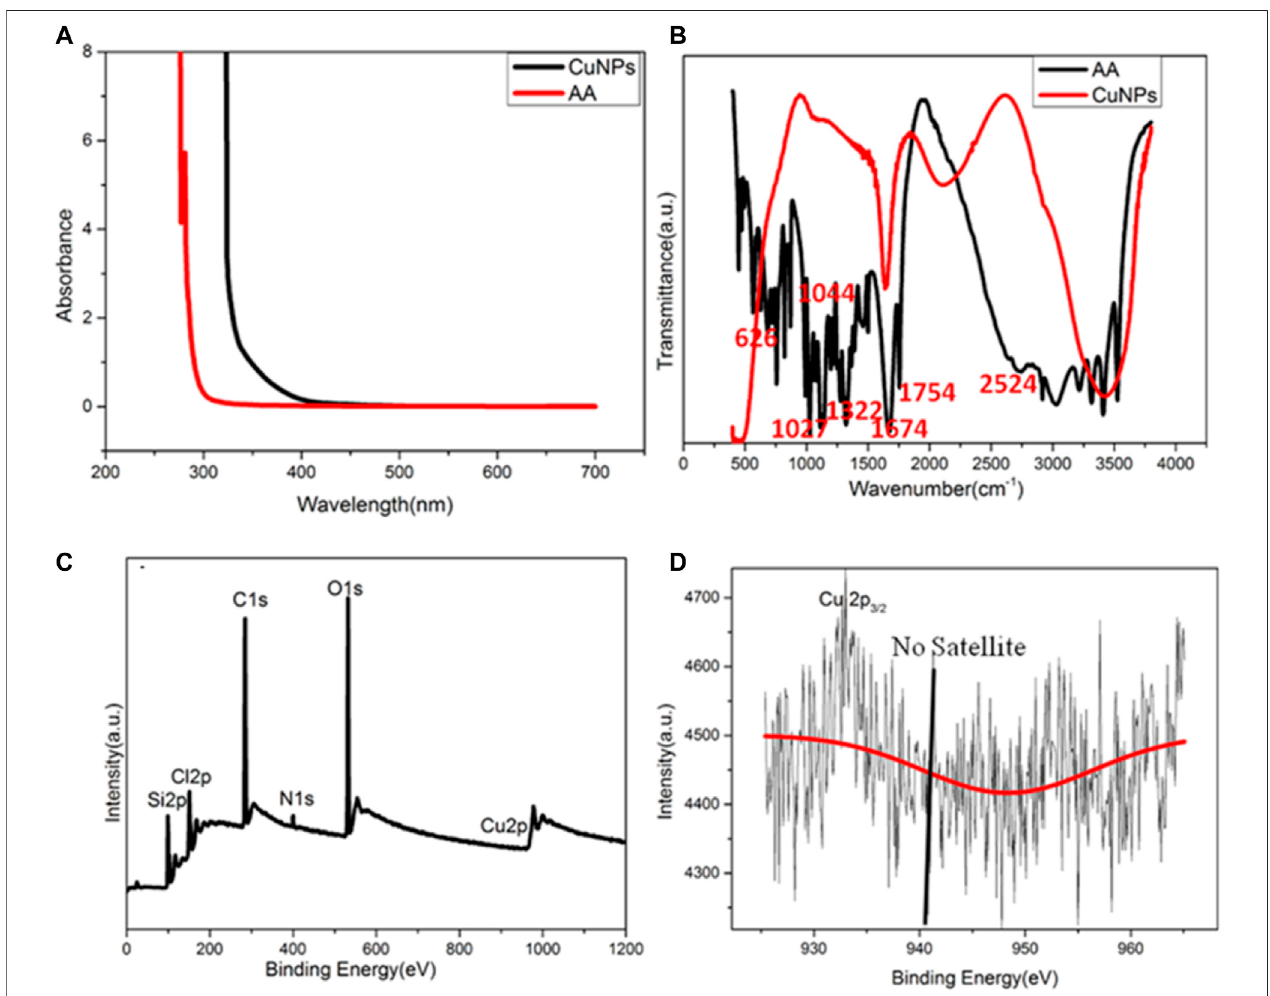
FIGURE 2 | (A) UV – vis spectra of CuNPs and AA; (B) FT-IR spectra of CuNPs and AA; (C) XPS of CuNPs thus obtained; (D) ampli fi ed XPS of Cu 2p electrons.